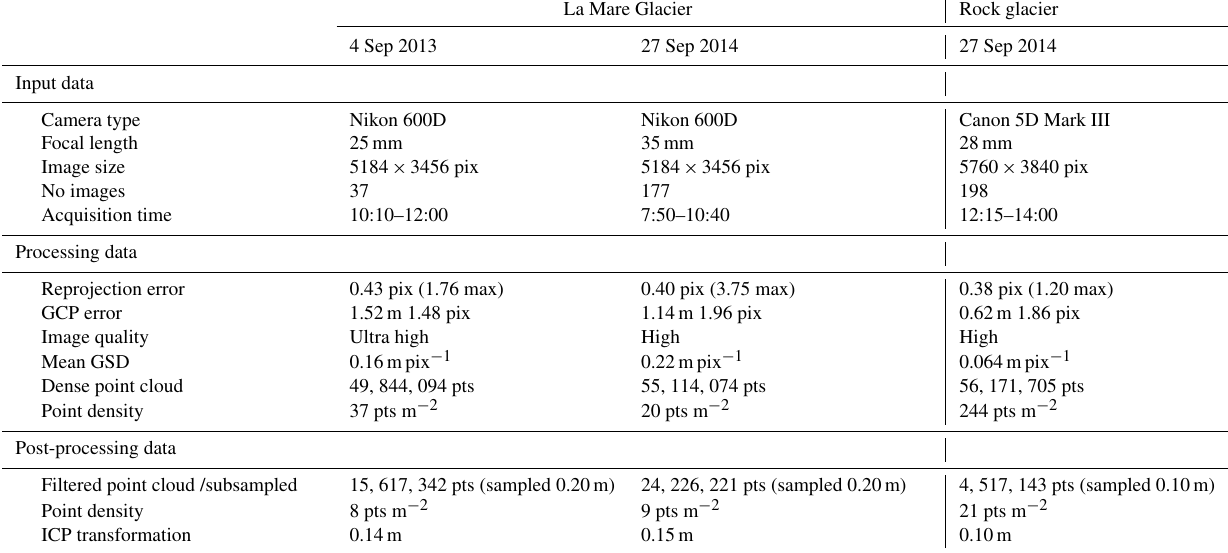
Table 2. Data acquisition settings and processing results of the photogrammetric surveys for both case studies. The GCP error is the average transformation residual error (m) and root mean square reprojection error for the GCPs (pix) during the bundle adjustment computation. The image quality refers to the downsampling of the image resolution during the dense matching computation. “Ultra high” means full resolution and “high” a downsampling of 50% before image matching procedure. The ground sample distance (GSD) is the average pixel size on the ground. The standard deviation of the ICP (Iterative Closest Point) registration is reported in the table. La Mare Glacier Rock